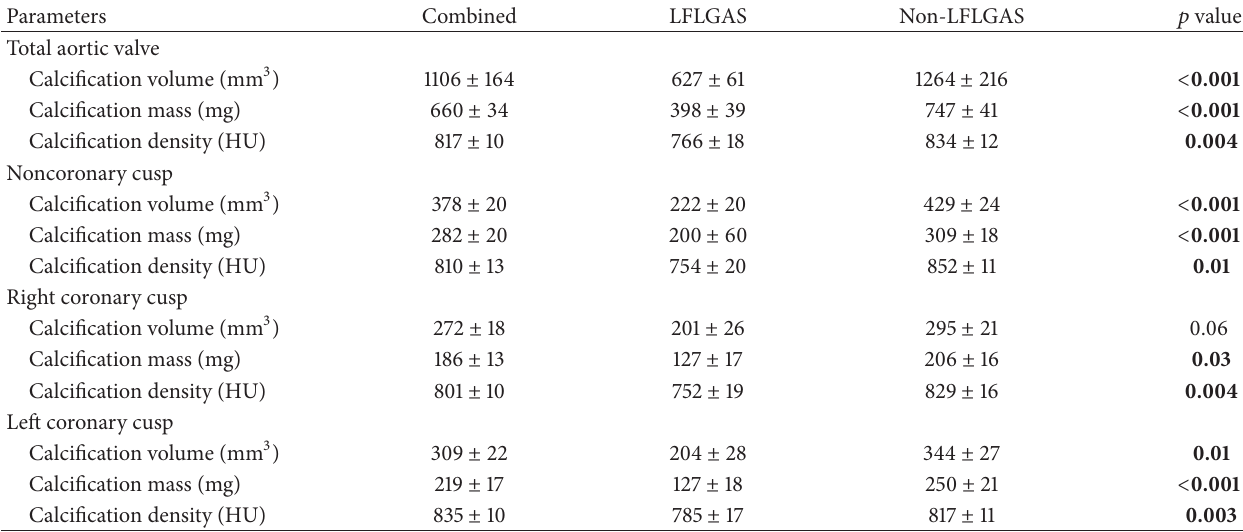
Table 2: Aortic valve calcification